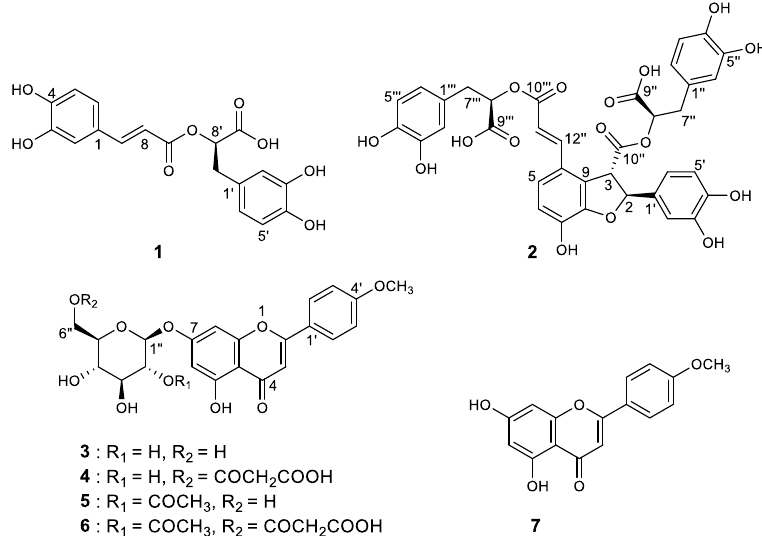
Figure 1. Structures of compounds 1 − 7 isolated from A. rugosa .